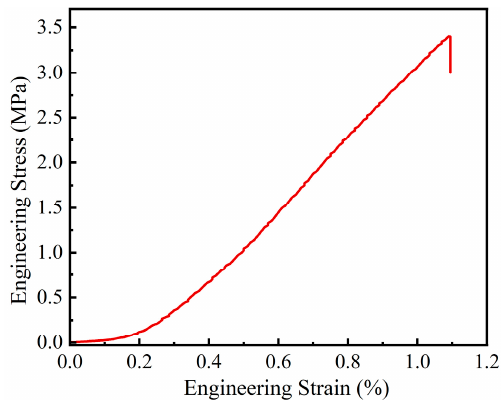
Figure 5. Tensile stress–strain curve of silver nanowire film.